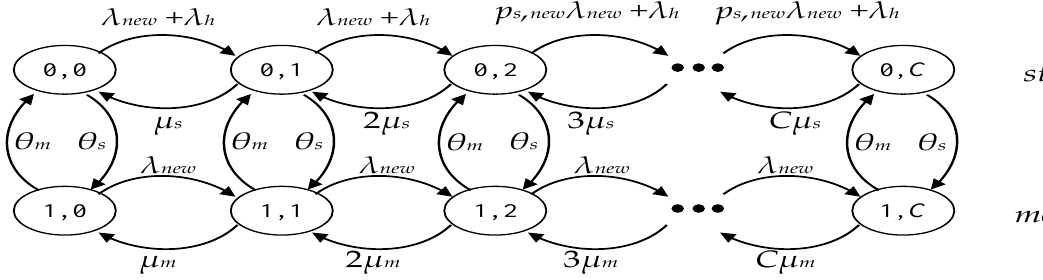
Figure 1. The 2-D state transition diagram in the proposed probabilistic BR loss model.